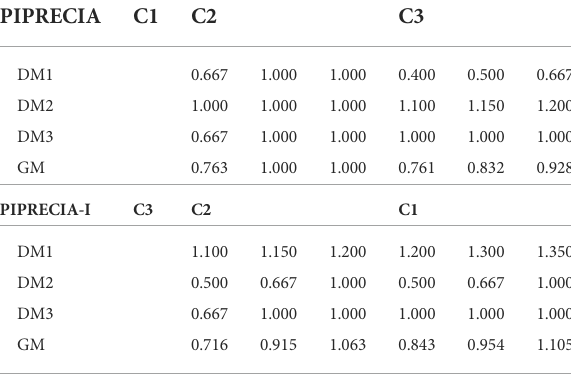
TABLE 4 Assessment of the key criteria using the fuzzy PIPRECIA method.